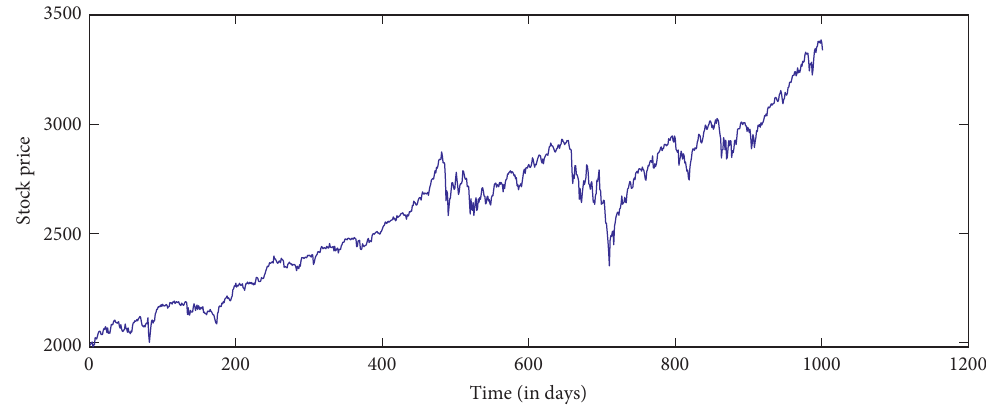
Figure 2: The daily S&P 500 stock price series. Table 2: Statistical properties of daily S&P 500 log return